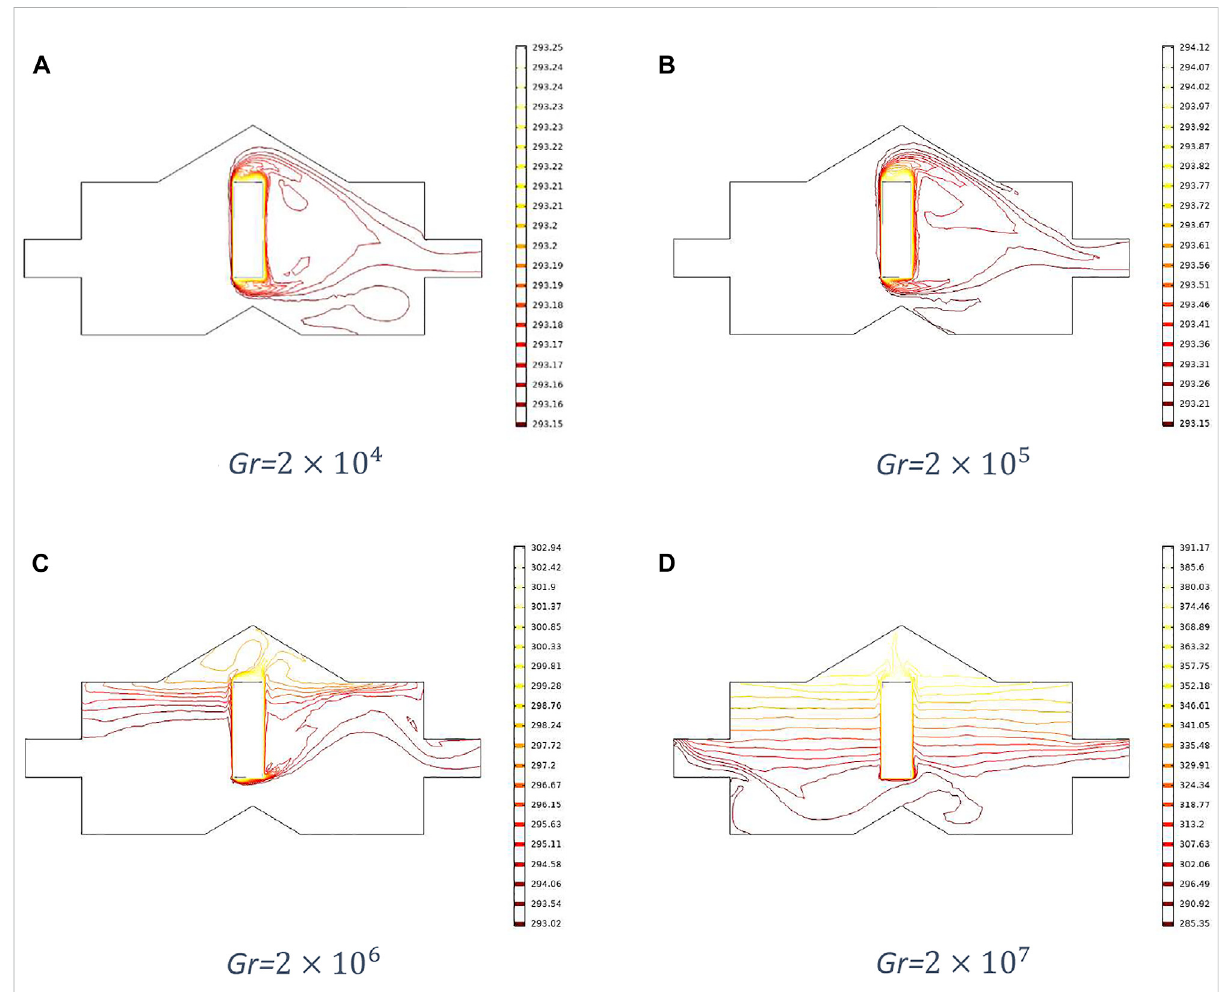
FIGURE 9 Isothermal contours at Re = 700 and at different Grashof